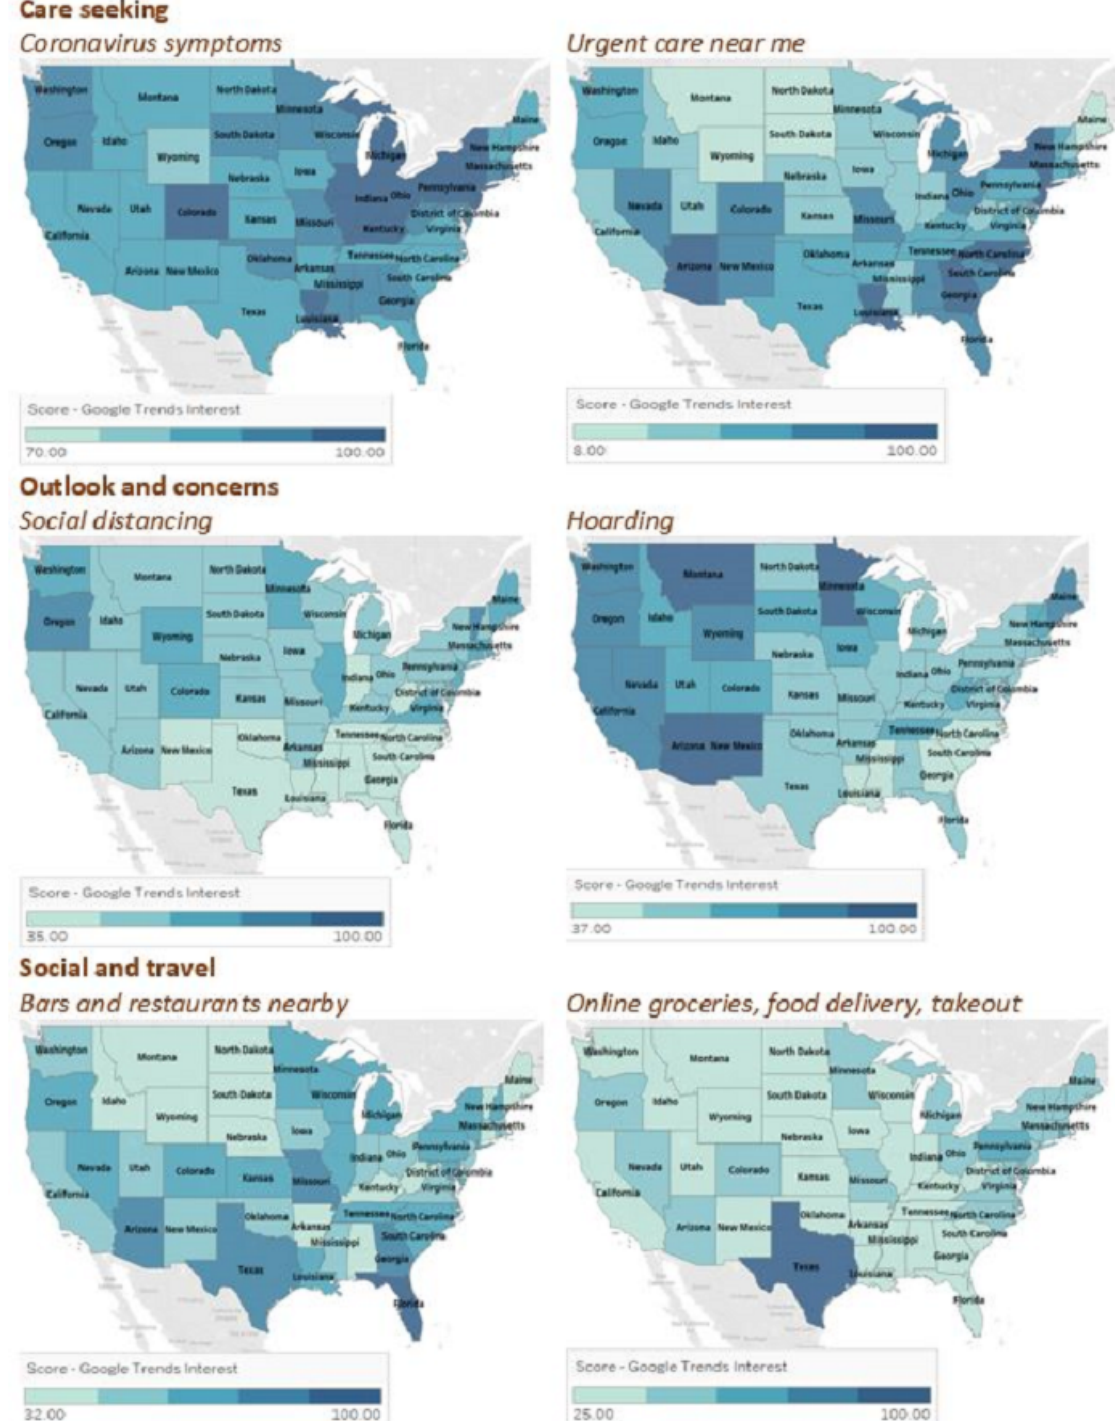
Figure 4. Geographical variations across states from March 1 to April 15, 2020, for the care seeking, outlook and concerns, and social and travel themes. The figure shows the two queries that were most representative of each